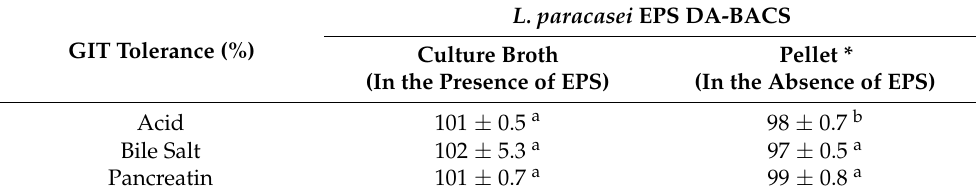
Table 1. Gastrointestinal tract tolerance of L. paracasei EPS DA-BACS. L. paracasei EPS DA-BACS GIT Tolerance (%) Culture Broth Pellet * (In the Presence of EPS) (In the Absence of EPS) Acid 101 ± 0.5 a 98 ± 0.7 b Bile Salt 102 ± 5.3 a 97 ± 0.5 a Pancreatin 101 ± 0.7 a 99 ± 0.8